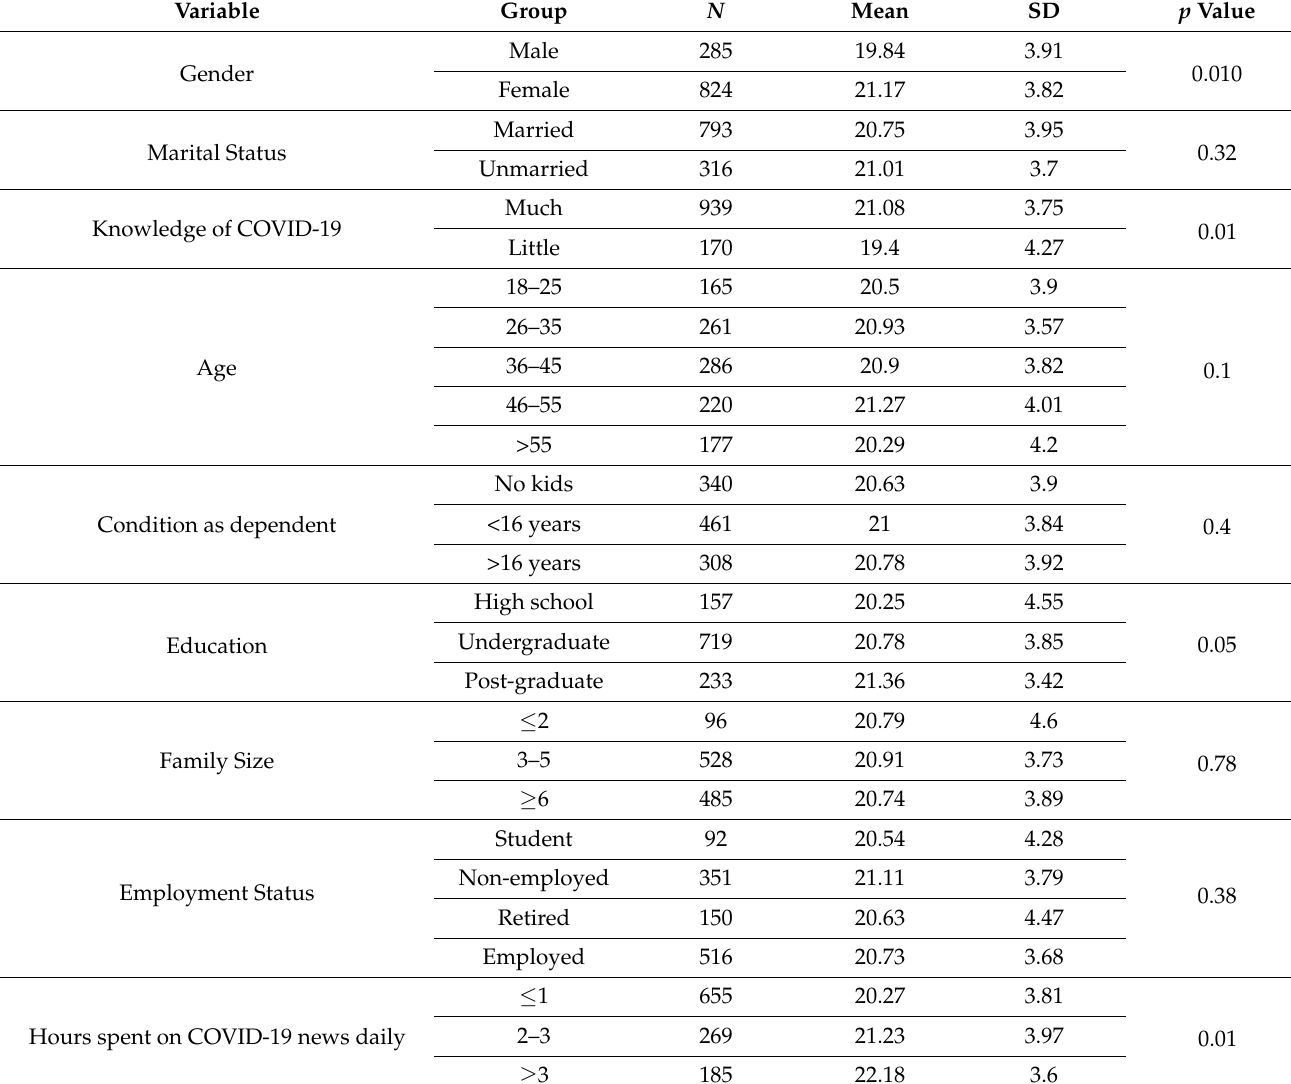
Table 2. Participants ( n = 1109) committed (mean, SD) to the precautionary measures in different sociodemographic groups and the p value of ANOVA indicating the significant effect of the